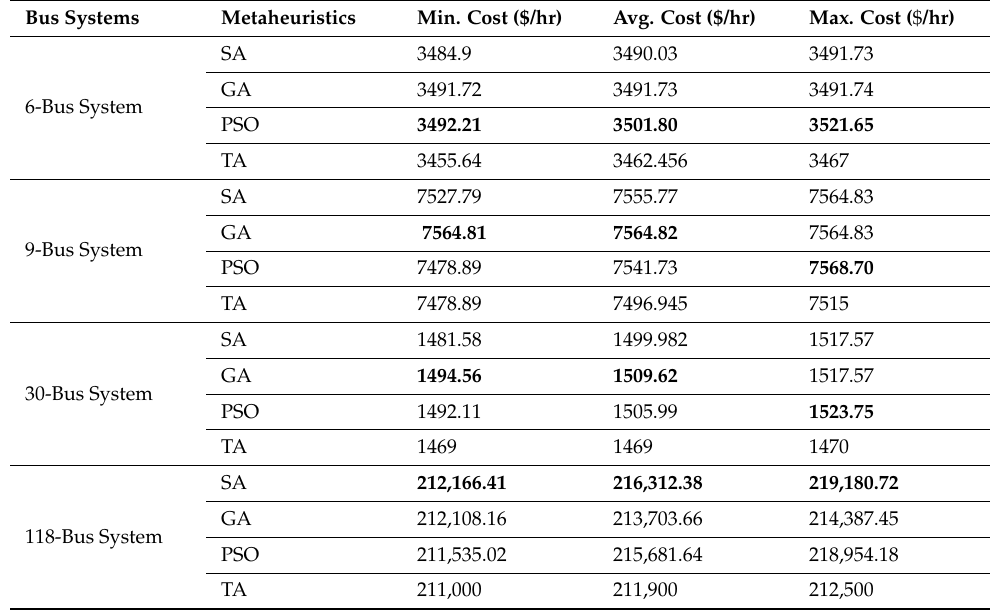
Table 5. Minimum, average, and Maximum cost increase under attack on different bus systems.